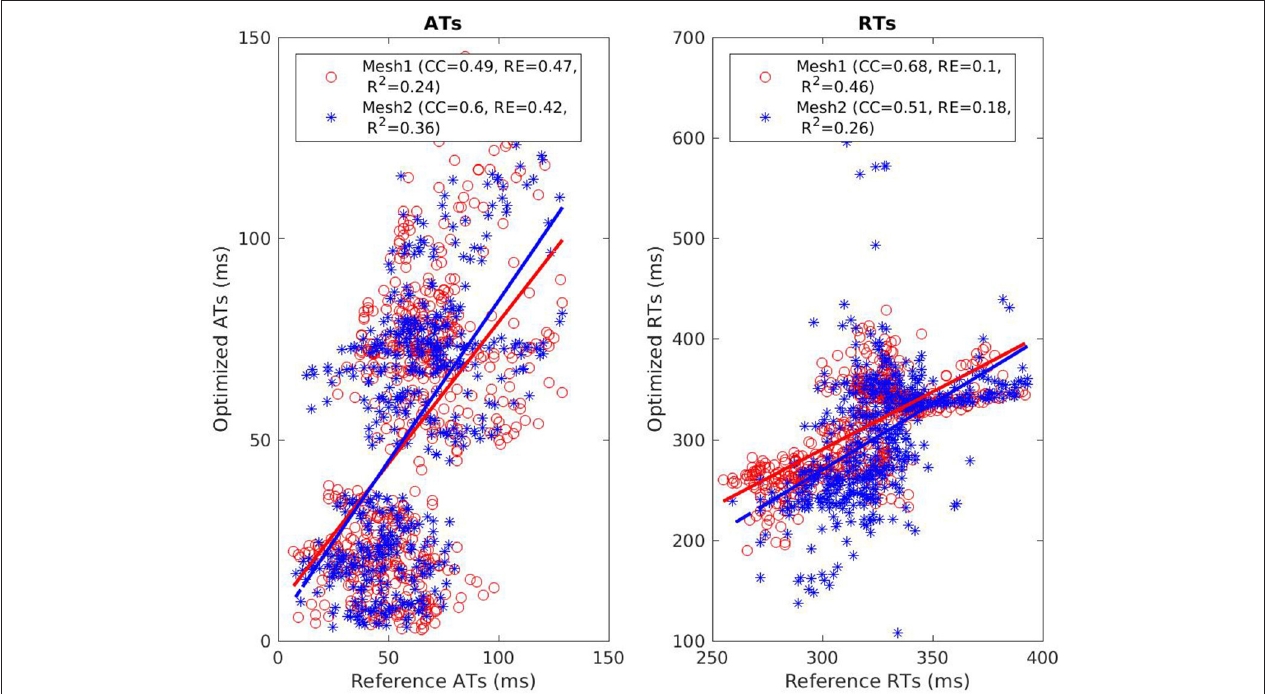
FIGURE 10 | Scatter plot of the ATs (left) and RTs (right) for the SR case. For each point, the x coordinate is the reference AT (resp. RT) and the y coordinate is the corresponding reconstructed AT (resp. RT). The dashed lines represent the linear fitting.